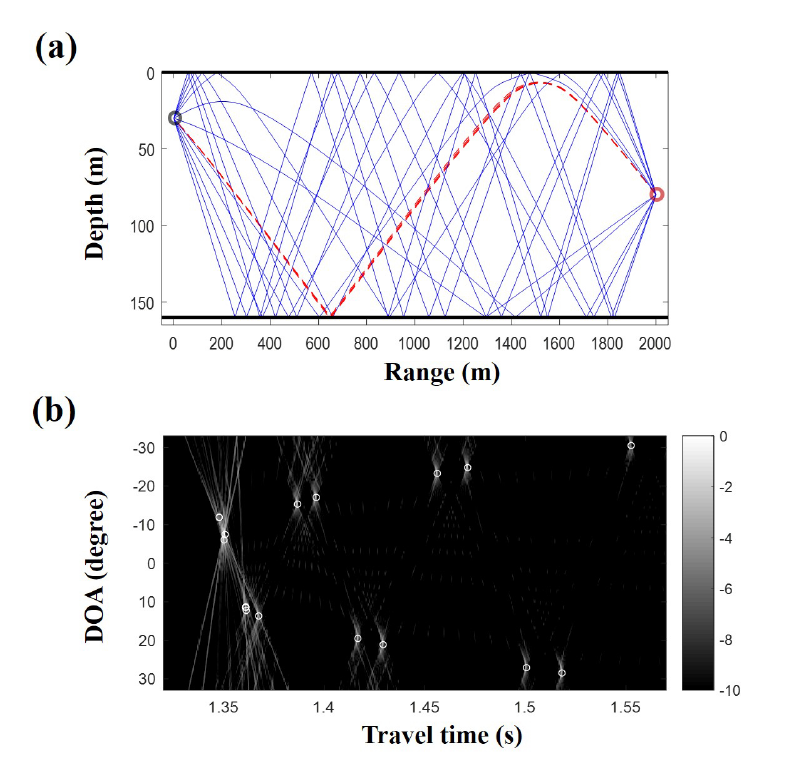
Figure 5. ( a ) trajectories of eigenrays with arrival angles less than 30 ◦ . Dashed lines correspond to ray trajectories for refracted rays; ( b ) arrival angles of eigenrays according to their travel times (o marks) overlaid on Figure 4b. They match well with the direction of arrivals from the